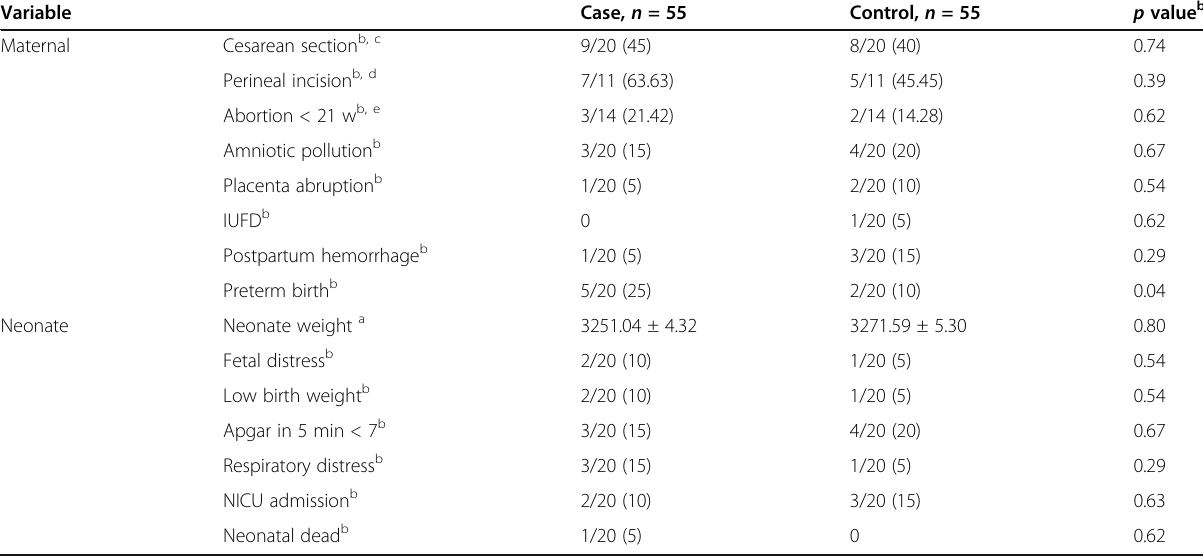
Table 5 Maternal and neonatal outcomes of the patients Variable